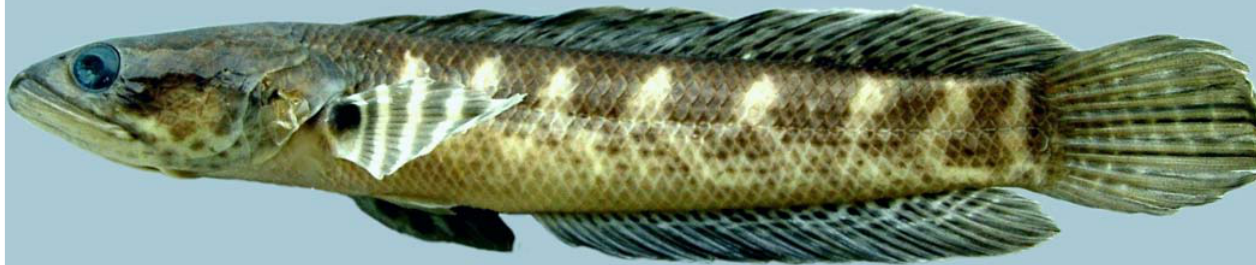
Image 2. Side view of Channa aurantimaculata (GUMF uncat.)